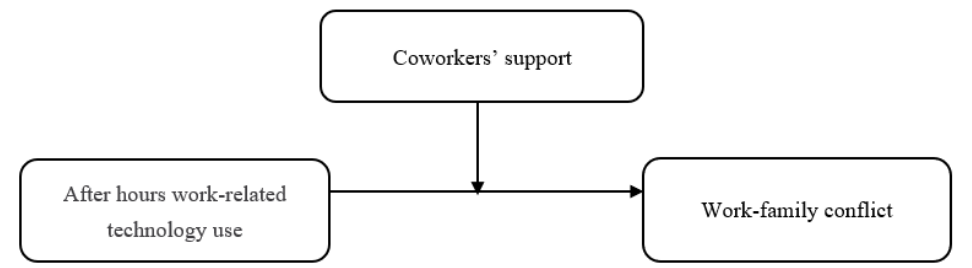
Figure 2. Relationship between after-hours work-related technology use, coworkers’ support, and work–family conflict.